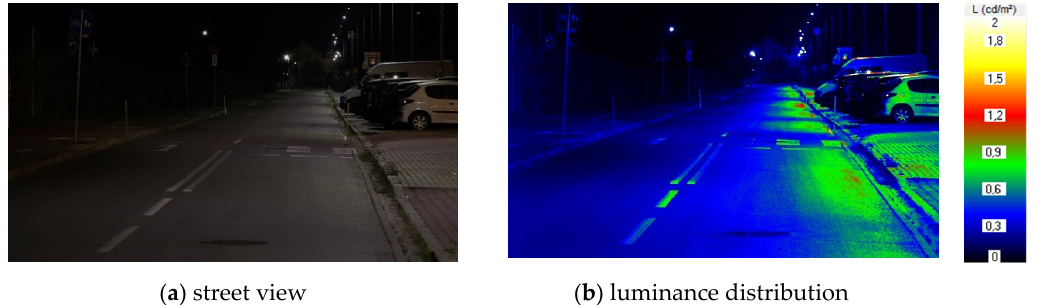
Figure 20. View of the street with lighting when the luminous flux Φ of the lamps is controlled to 57% (average luminance of the roadway is Lav = 0.43 cd/m 2 ).